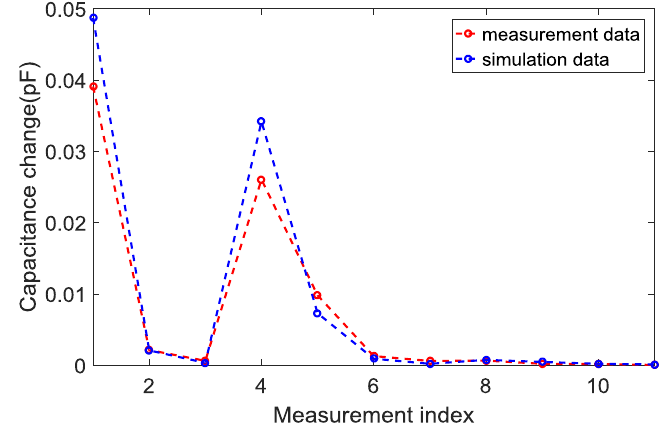
Figure 3. Dynamic range of the capacitance change in electrode 1.